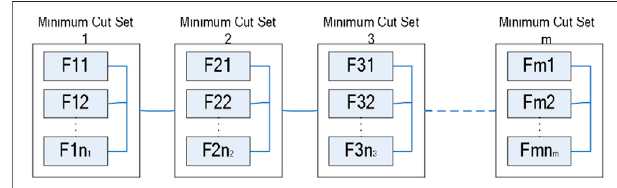
FIGURE 3 | Block diagram of minimum cut